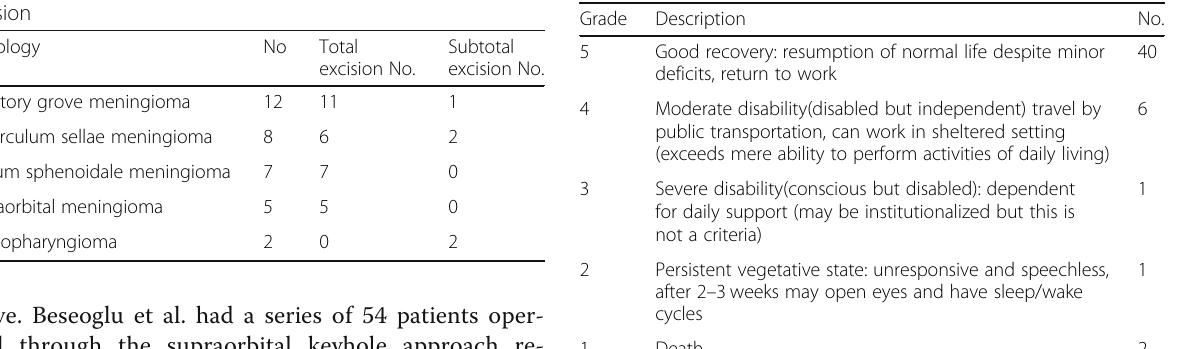
Table 4 Clinical outcome according to Glasgow Outcome